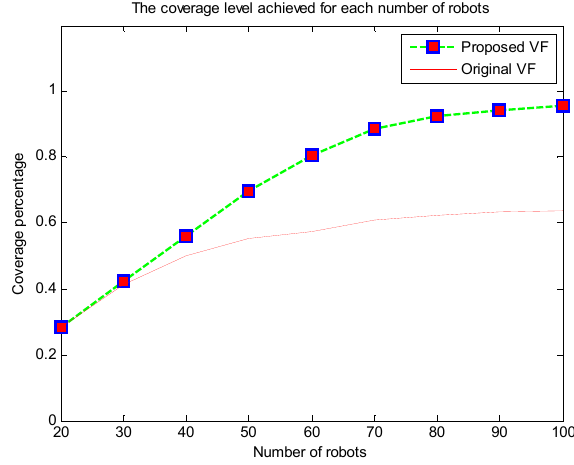
Figure 9. The coverage level achieved for each number of robots.